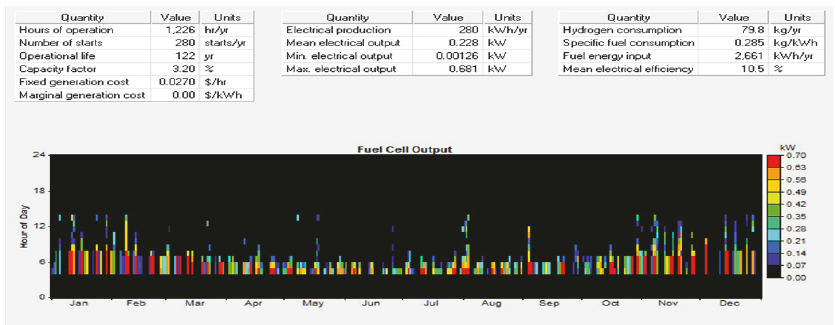
Figure 5: HOMER software results for the fuel cell inputs.